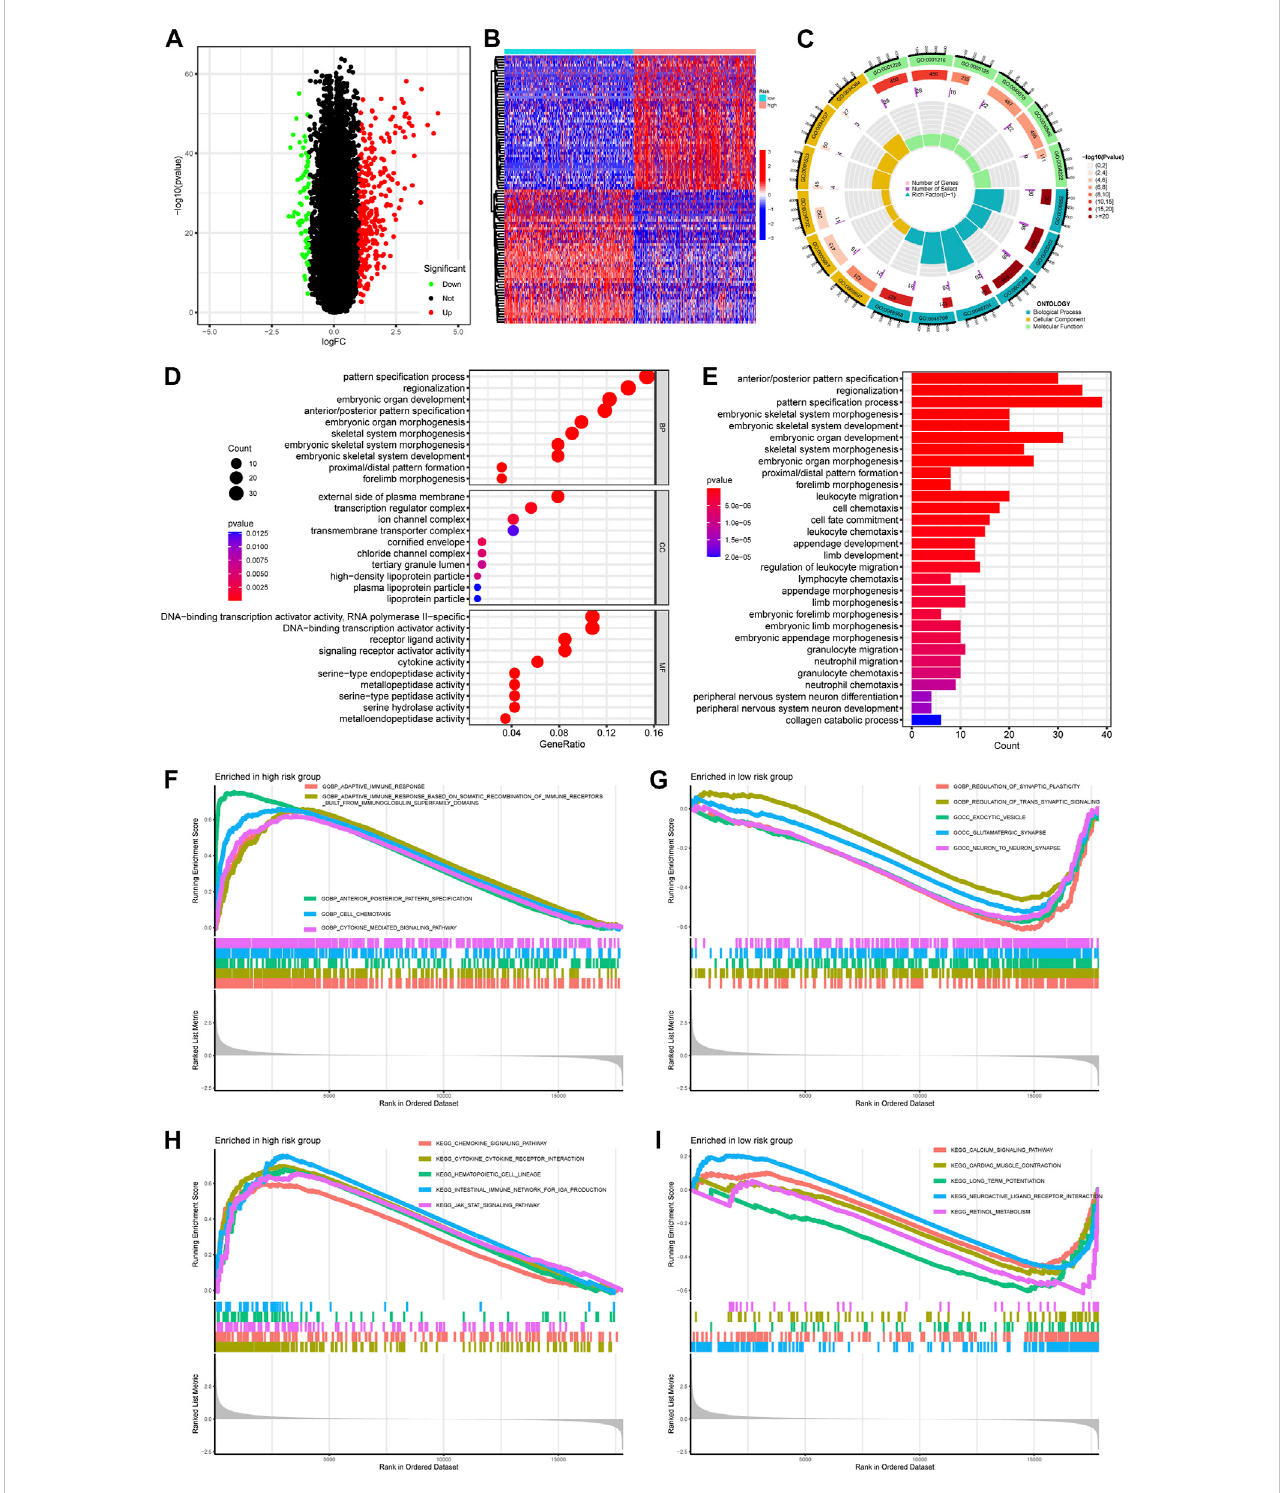
FIGURE 4 Pathway enrichment comparing gene expression pro fi les between high- and low-risk groups. (A) Volcano plot showing the DEGs between risk groups. Signi fi cance threshold was setas |logFC| > 1 and padj < 0.05. Genesthat are signi fi cantly upregulated or downregulated inhigh-risk group werelabeled as red or green, respectively. (B) Heatmap showing the expression pattern of top 50 DEGs up- or downregulated in high-risk group. (C,D) GO enrichment of DEGs. (E) KEGGenrichmentofDEGs. (F,G) GSEAenrichmentofGOtermscomparinghigh-andlow-riskgliomasamples. (H,I) GSEAenrichmentofKEGGterms comparing high-and low-risk glioma samples. Abbreviation: GO, gene ontology; BP, biological process; MF, molecular function; CC, cellular component; KEGG, Kyoto Encyclopedia of Genes and Genomes; GSEA, gene set enrichment